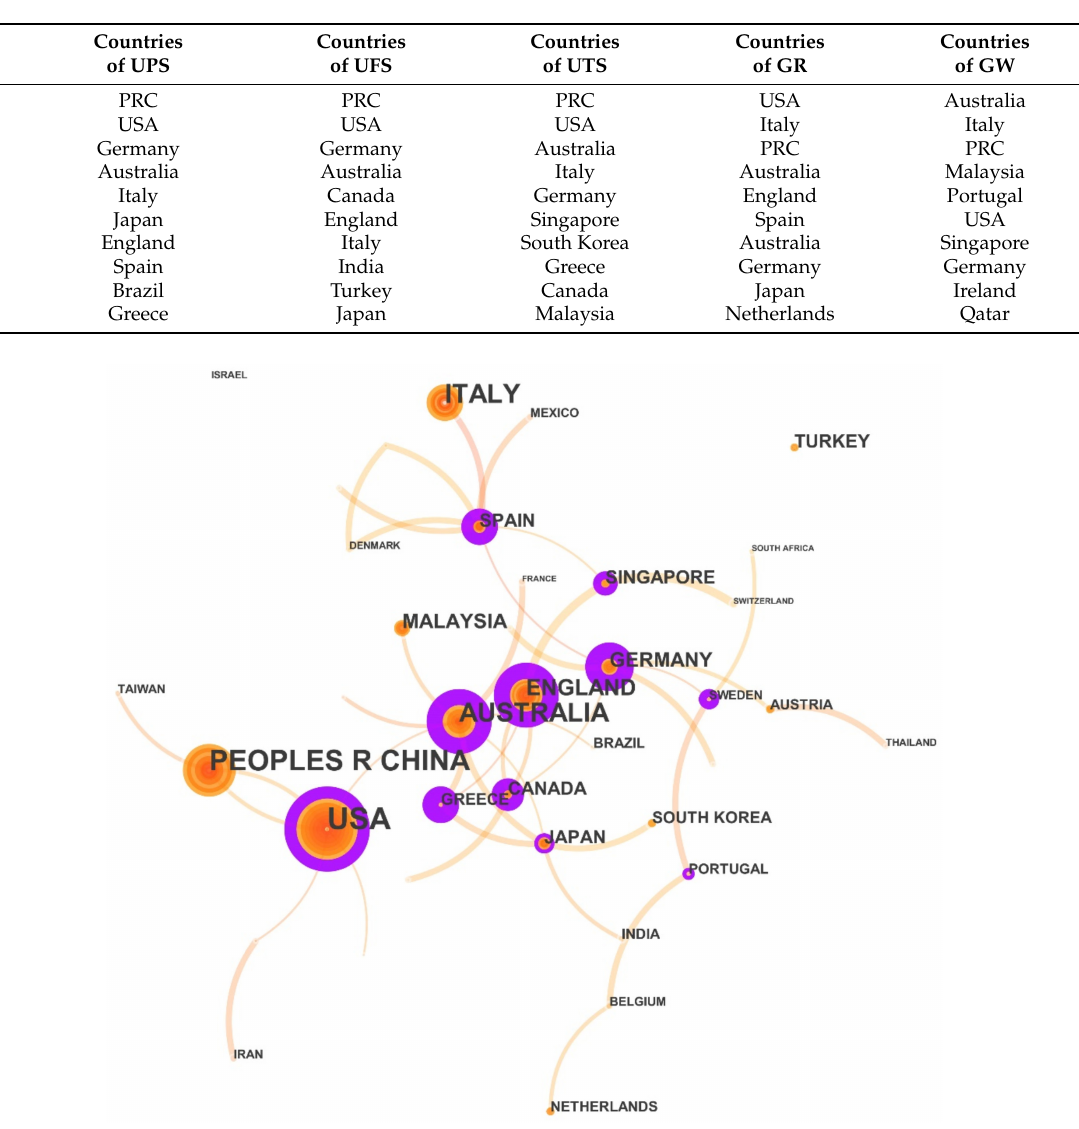
Table 2. Top 10 countries by publications on different GI types, 1990–2021.